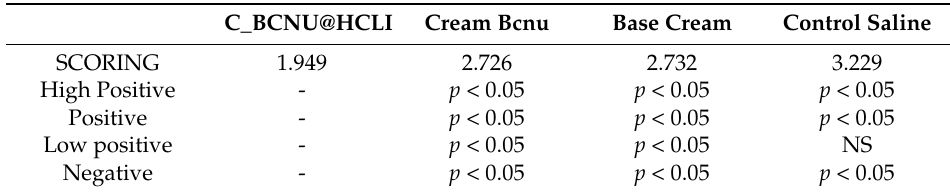
Table 9. Cox-2 expression level: scoring and levels of significance in paired comparison of the new formulation and the control type treatments; (IHC